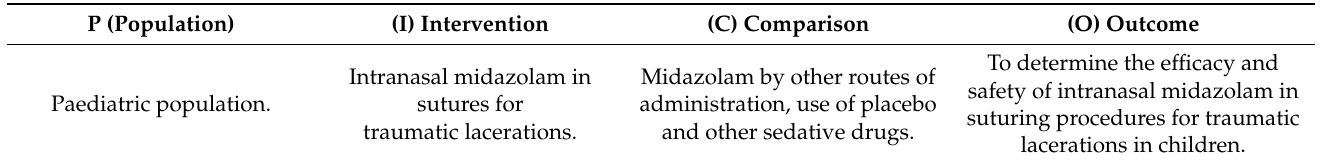
Table 1. PICO question